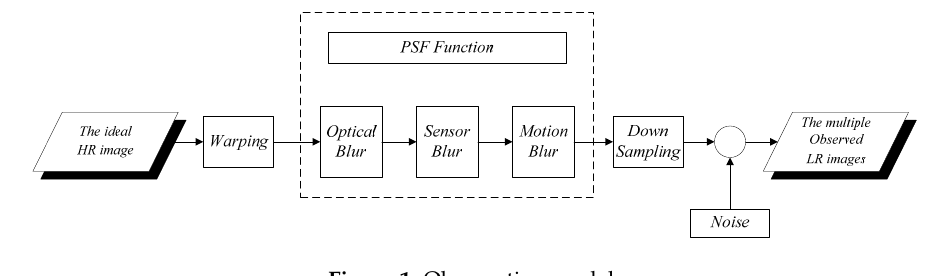
Figure 1. Observation model.